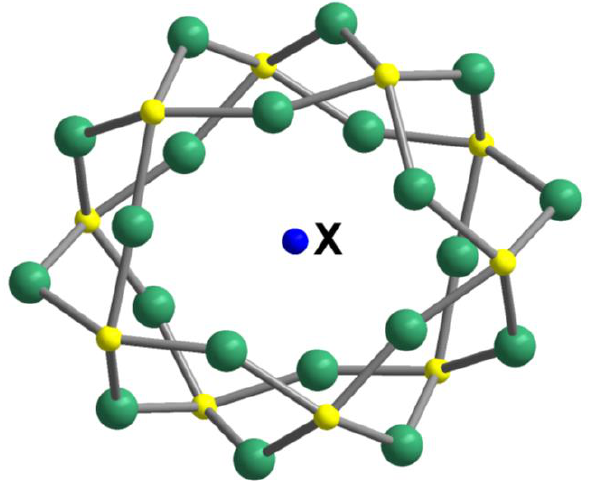
Scheme 1. The structure of {X@Ag 20 (SR) 10 } core when X atom indicates center of gravity for the guest molecule, Ag is green, S is yellow. Organic radicals are omitted for clarity.